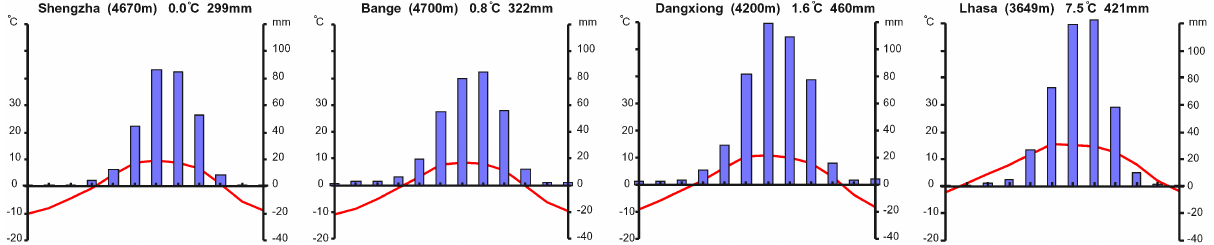
Fig. 2. Climate diagrams of Shengzha (also: Xainza), Bange (also: Bamgoin), Damxiong (also: Damxung), and Lhasa. The values are based on the period 1971–2000. Data source: National Climate Center of the Chinese Meteorological Administration; for the location of the climate stations see Fig.